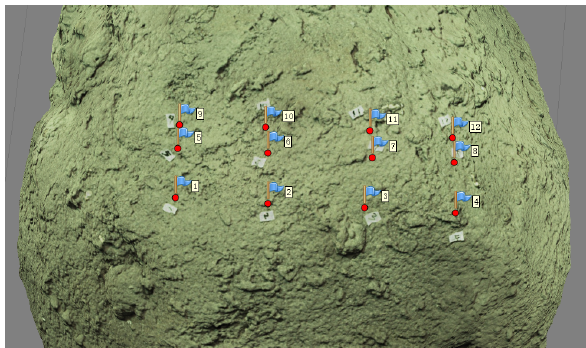
Figure 8. The control points and check points.